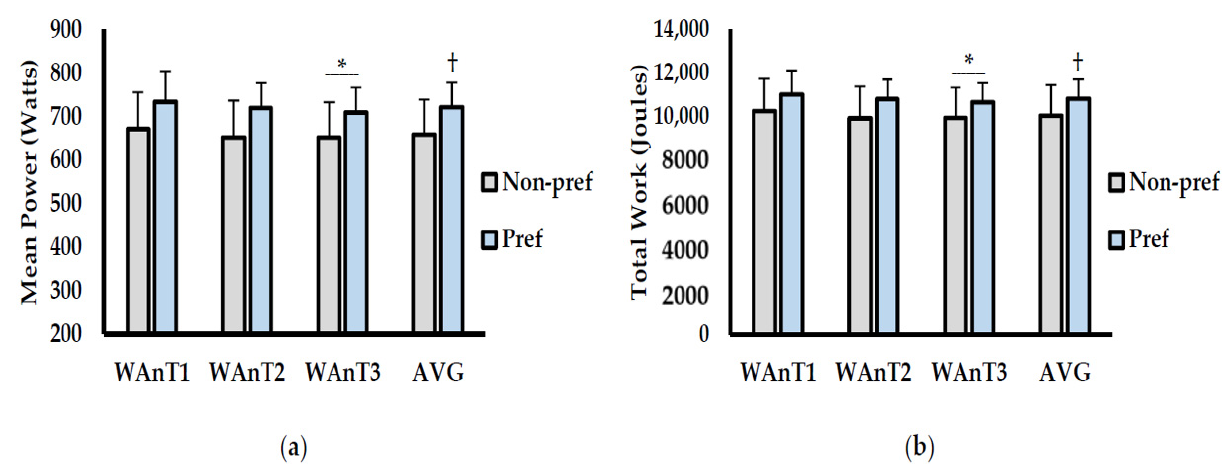
Figure 1. ( a ) Mean power (watts) and ( b ) total work (joules) between non-preferred (Non-Pref; grey bars) and preferred (Pref; blue bars) warm-up music conditions. Measurements are shown for WAnT1, WAnT2, WAnT3, and the average of all three tests together (AVG) for each condition. Data are presented as mean ± SD. * indicates significantly different from WAnT1 ( p ≤ 0.05). † indicates significantly different than Non-pref ( p ≤ 0.05).